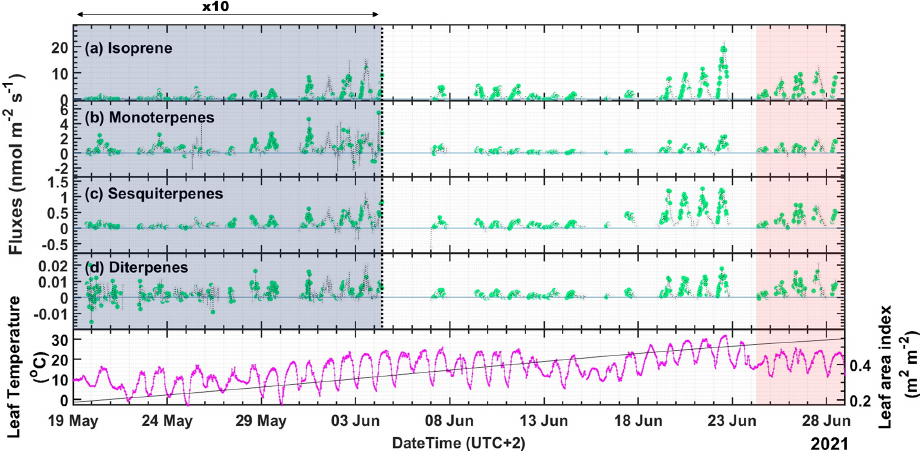
Figure 2. Fluxes of terpenes (a–d) and leaf temperature with leaf area index (LAI) (bottom panel) measured throughout the campaign. Note that the panels (a) – (d) are split into two, and the flux measurements up to 4 June are multiplied by 10 to increase the visibility of the lower values earlier in the campaign. Data points colored in green (class 1–3) are good quality flux periods and are used for fundamental research. The gray data points can only be used for orientation of flux or other general purposes. The red shaded area is the period after the maximum temperature day, 22 June 2021, when the highest air temperature above 31 ◦ C was recorded and is referred to as the “high-temperature stress period” in the